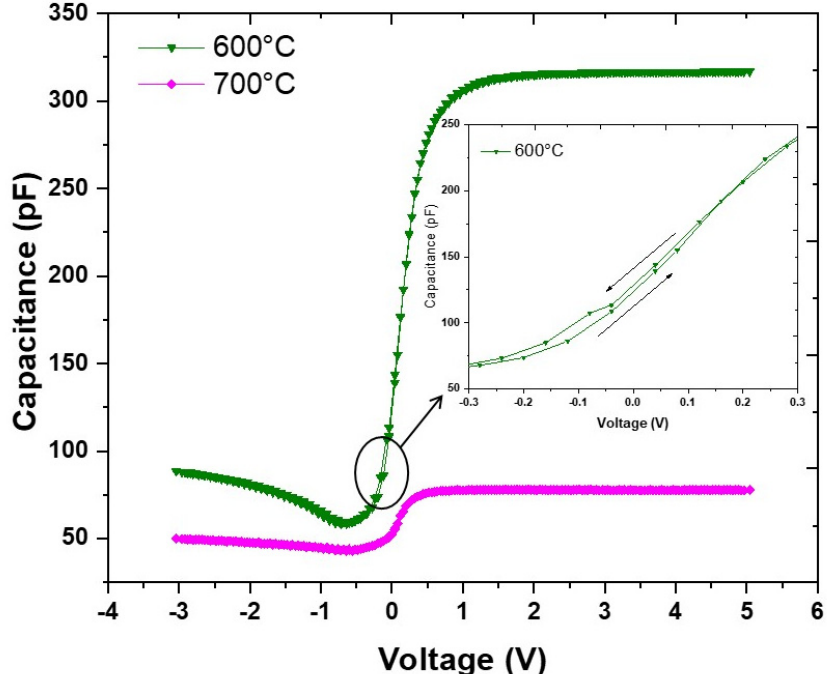
Figure 4. ( a ) C–V characteristics curves at 1 MHz of Hg-LMO-Si MOS structures obtained for the LMO film as deposited and after annealing with the values of the relative dielectric constants K. ( b ) Flat band voltage V FB (black curve) and dielectric constant (red curve) in function of different annealing temperatures.